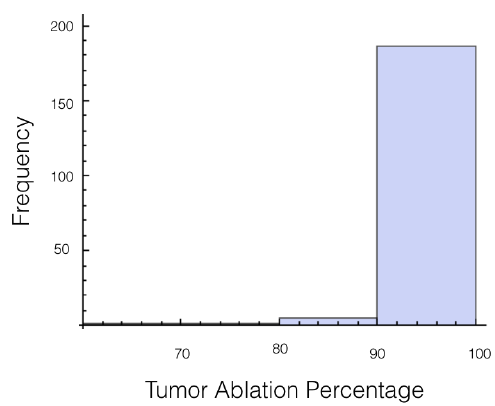
Figure 4. Histogram for percentage of tumor above 700 V/cm for case 1 at 2000